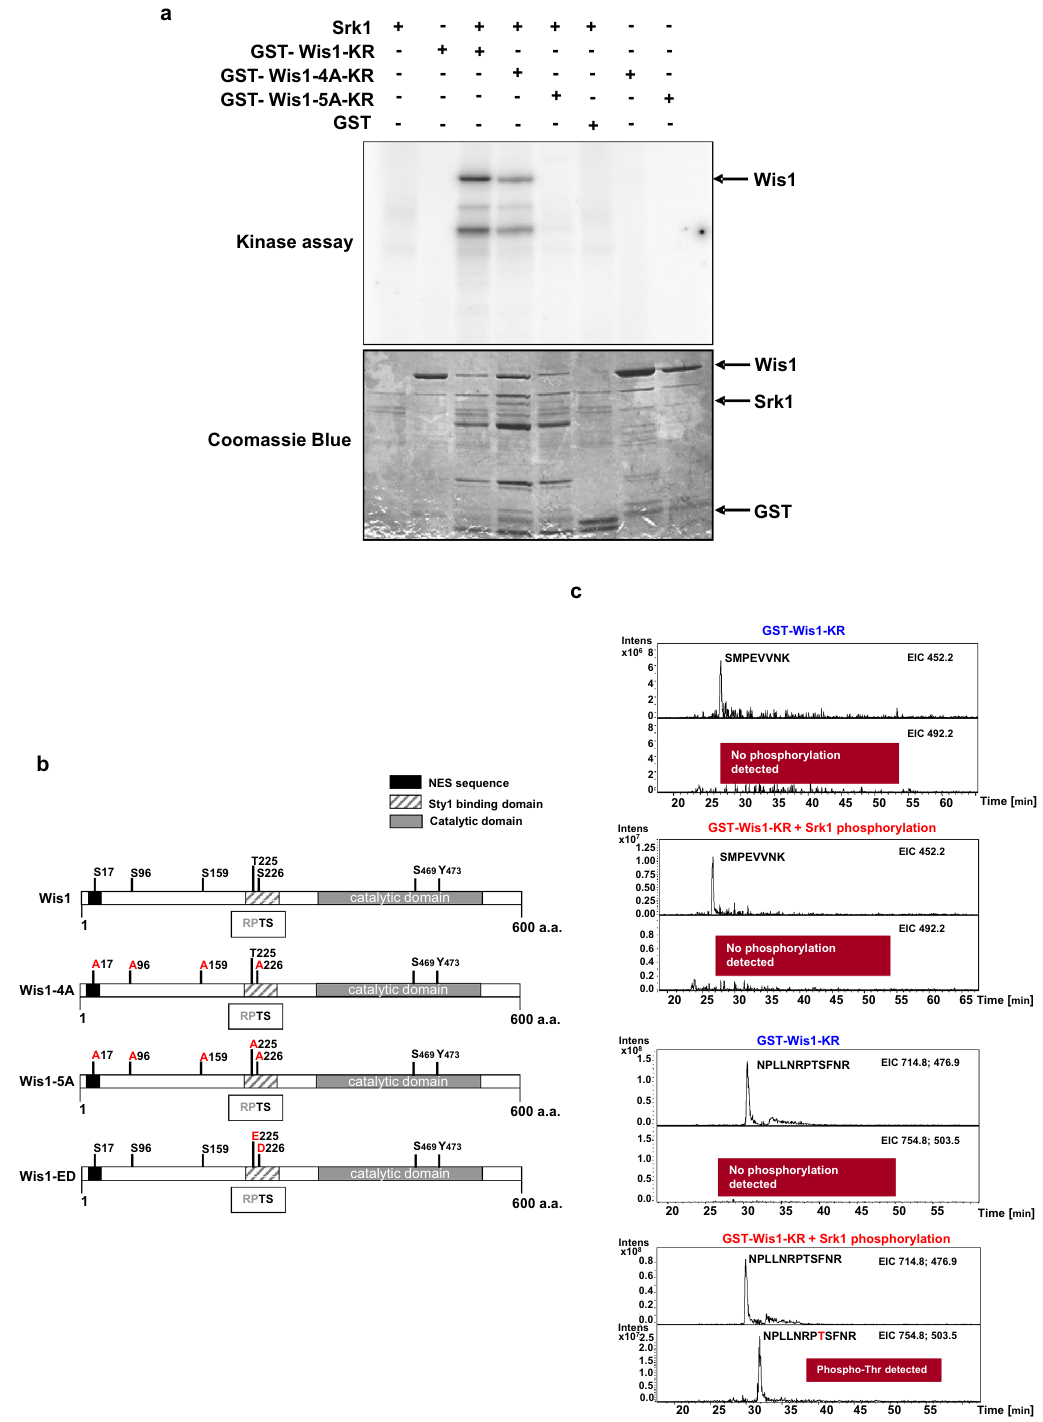
Figure 5. Wis1 is phosphorylated by Srk1 ( a ) Recombinant Srk1, GST-tagged Wis1-KR (catalytically inactive) Wis1-4A-KR, and Wis1-5A-KR were incubated separately or together with γ 32 P-ATP in the absence or presence of recombinant Srk1. The autoradiogram (top) and Coomassie blue (bottom) results are shown. ( b ) Schematic representation of Wis1 protein domains and the different mutations performed to obtain Wis1 phospho- mutants (see text for details). ( c ) In vitro phosphorylation assays with recombinant GST-Wis1-KR without (blue planels) or with recombinant GST-Srk1 (red panels) and processed for LC–MS phosphopeptide analysis. Two peptides are shown, peptide SMPVVNK (159–166 AA) (first two panels) and peptide NPLLNRPTSFNR (218–229 AA) (last two